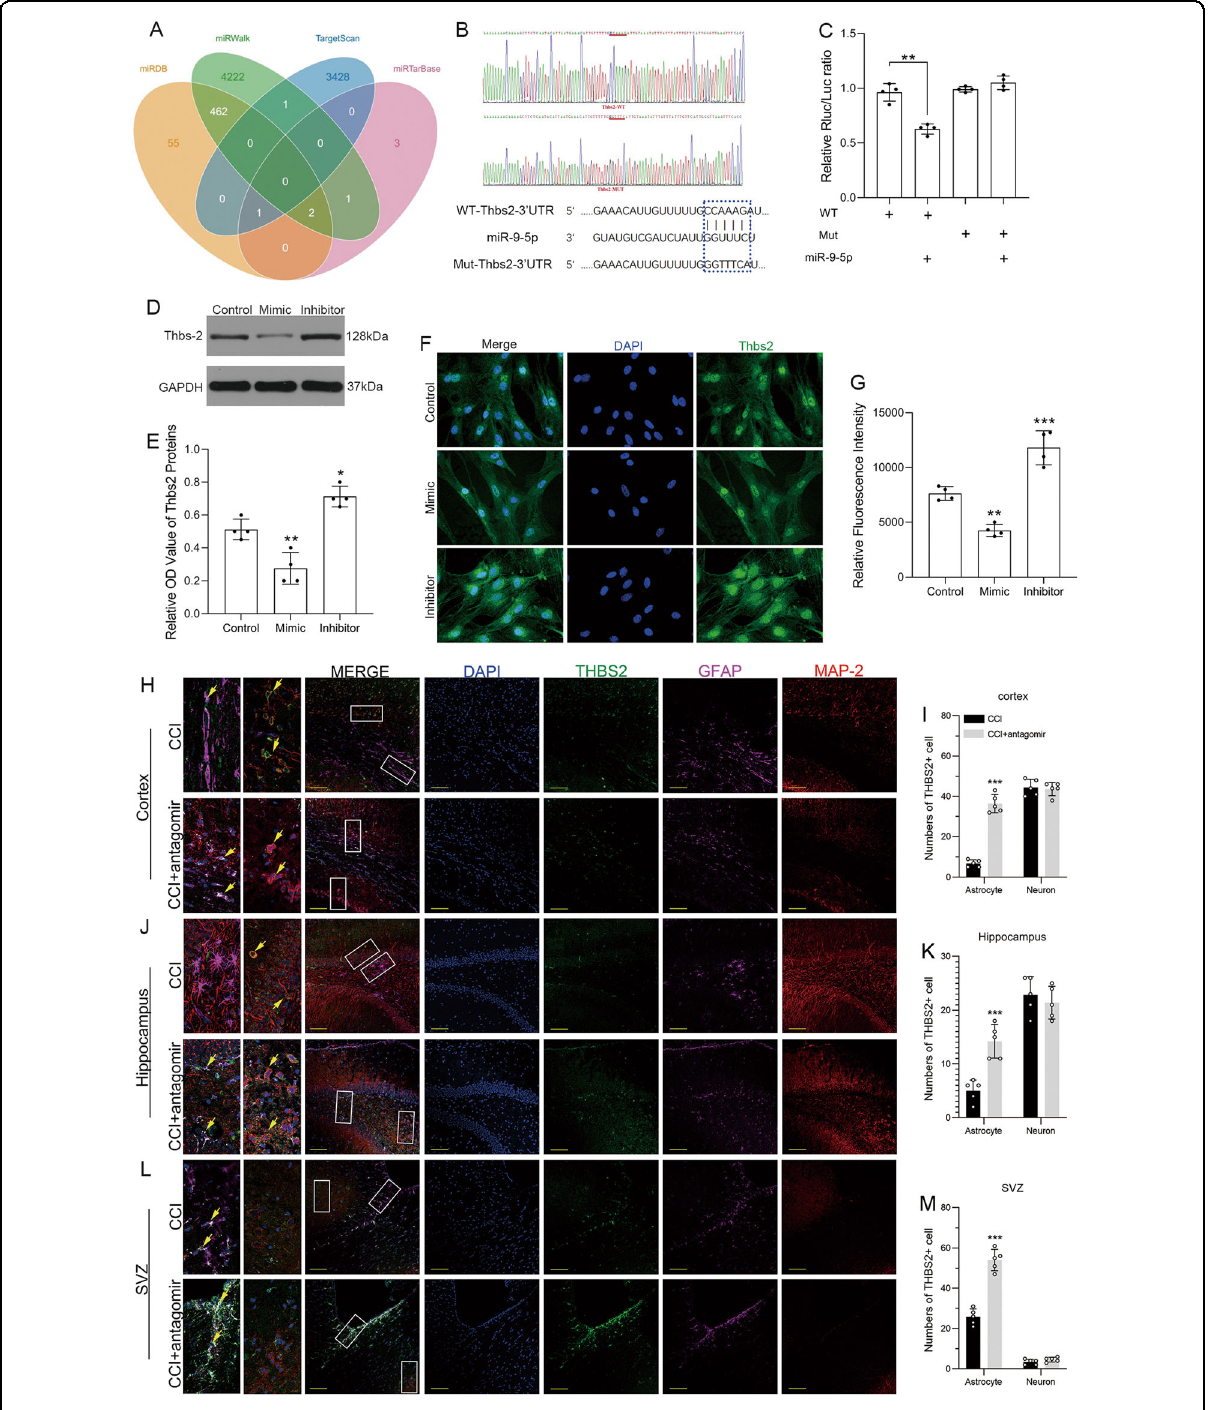
Fig. 3 miRNA-9-5p targeted the 3 ′ UTR of Thbs-2 mRNA, and downregulation of miRNA-9-5p promoted the expression of Thbs-2 in astrocytes. A Prediction of the miRNA-9-5p target and B construction of the Thbs-2 mutation site. C The dual luciferase reporter assay (* P < 0.05, ** P < 0.01 versus the WT group). D The immunoblotting and E quantitative data of Thbs-2 in astrocytes. F The immuno fl uorescence (bar = 100 μ m) and G quantitative data of Thbs-2 in astrocytes ( n = 4/group) (* P < 0.05, ** P < 0.01, *** P < 0.001 versus the control group). H The immuno fl uorescence (bar = 100 μ m) and I quantitative data of Thbs-2 in the cortex. J The immuno fl uorescence (bar = 100 μ m) and K quantitative data of Thbs-2 in the hippocampus. L The immuno fl uorescence (bar = 100 μ m) and M quantitative data of Thbs-2 in the SVZ ( n = 5/group) (* P < 0.05, ** P < 0.01, *** P < 0.001 versus the CCI group) (WT: wild type, Mut: mutant type, CCI: control cortex impact, SVZ: subventricular zone). Error bars indicate mean ±